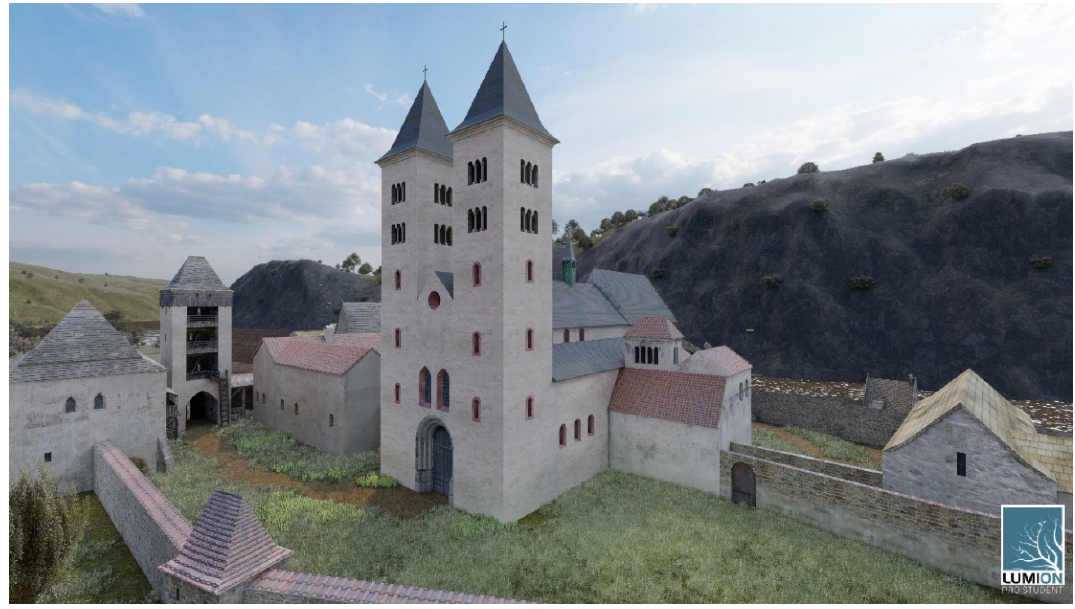
Figure A4. Visualization of the monastery in the Gothic era.